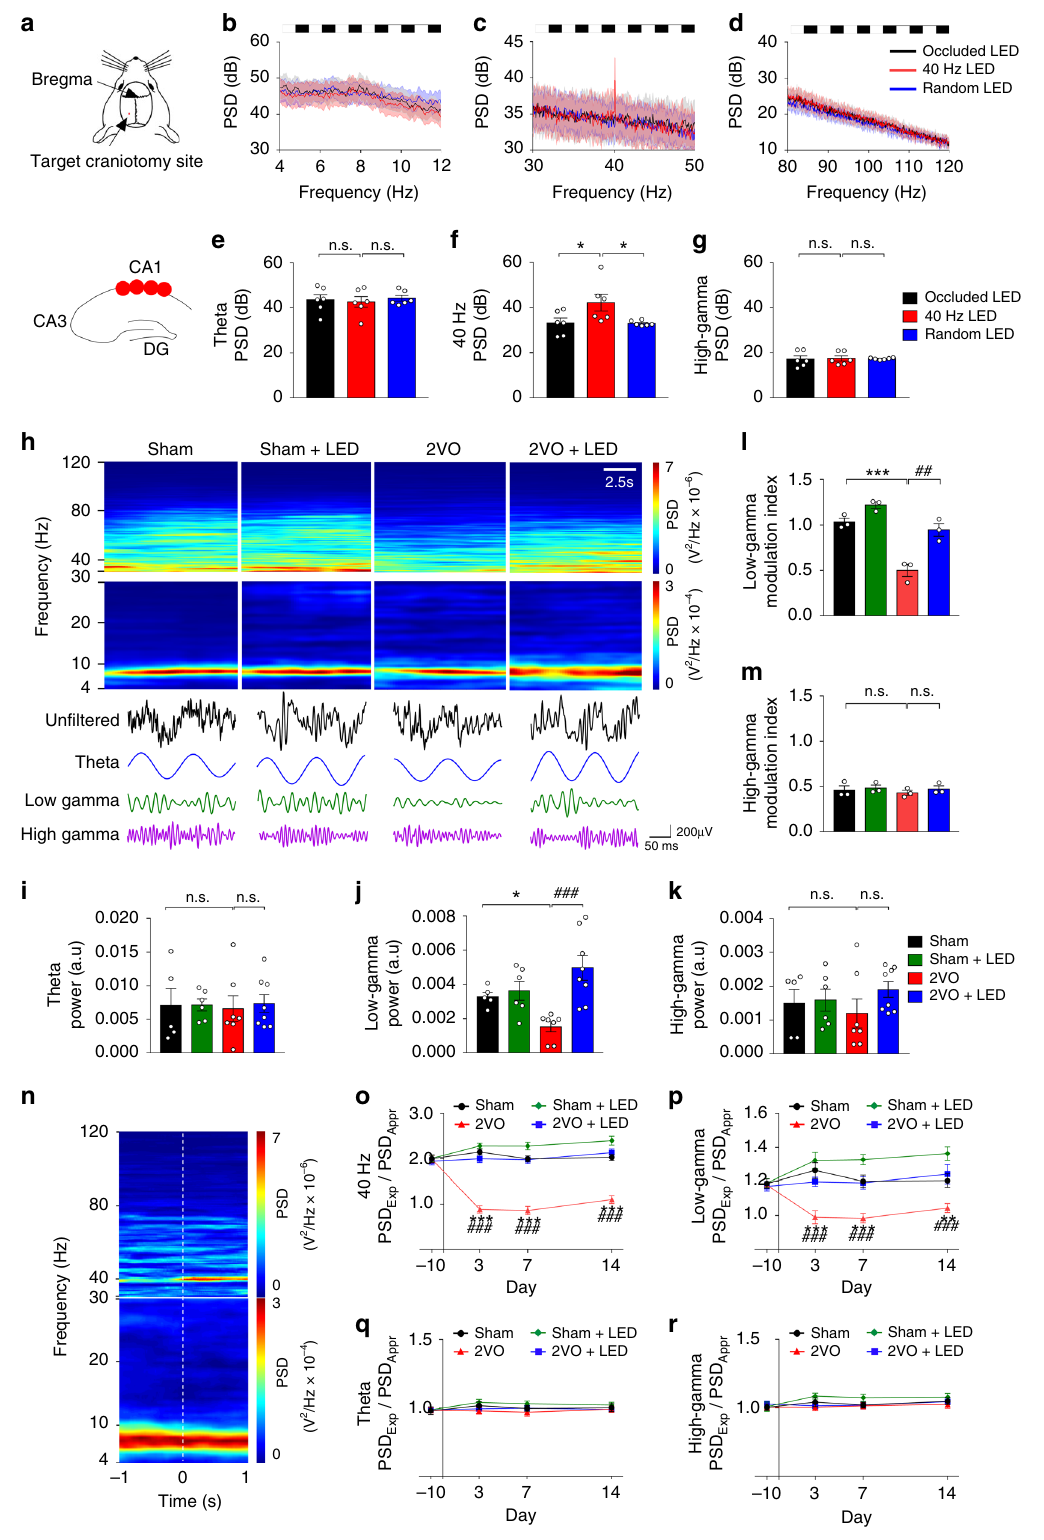
Fig. 2b, c), demonstrating remarkable neuroprotection to CA1 neurons. 40 Hz light fl icker treatment signi fi cantly reduced CA1 neurons by 40 Hz light fl icker. FJB positive neurons in the 2VO + LED group (2ANOVA: F (1, = 23.75, P < 0.0001, with LSD ’ s post hoc test for 2VO vs. 2VO Delayed light treatment at 3 d after 2VO was not neuropro- 30) + LED: P = 0.0014, P = 0.0072, P = 0.0495, Fig. 2c). tective compared with the early treatment group (2 h after 2VO) 3day 7day 14day (Two-tailed unpaired t-test, t (9) = 2.317, P = 0.0457, Fig. 2b, the At 14 d post 2VO, FJB positive cells were not present in the CA1 last column on the right and Fig. 2d). Reparably, light fl ickers region of mice treated with 40 Hz LED light (2VO + LED group,